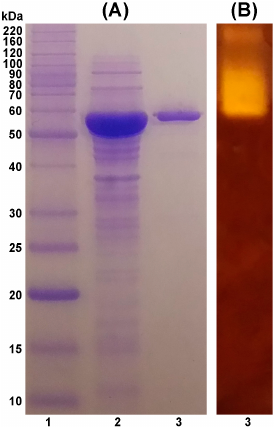
Figure 1. ( A ) SDS-PAGE (12%) separation of TASKA; ( B ) Zymogram for the amylolytic activity of TASKA. Lane 1, Molecular mass protein marker (BenchMark™ Protein Ladder, Life Technologies, Carlsbad, CA, USA); Lane 2, crude enzyme; Lane 3, purified